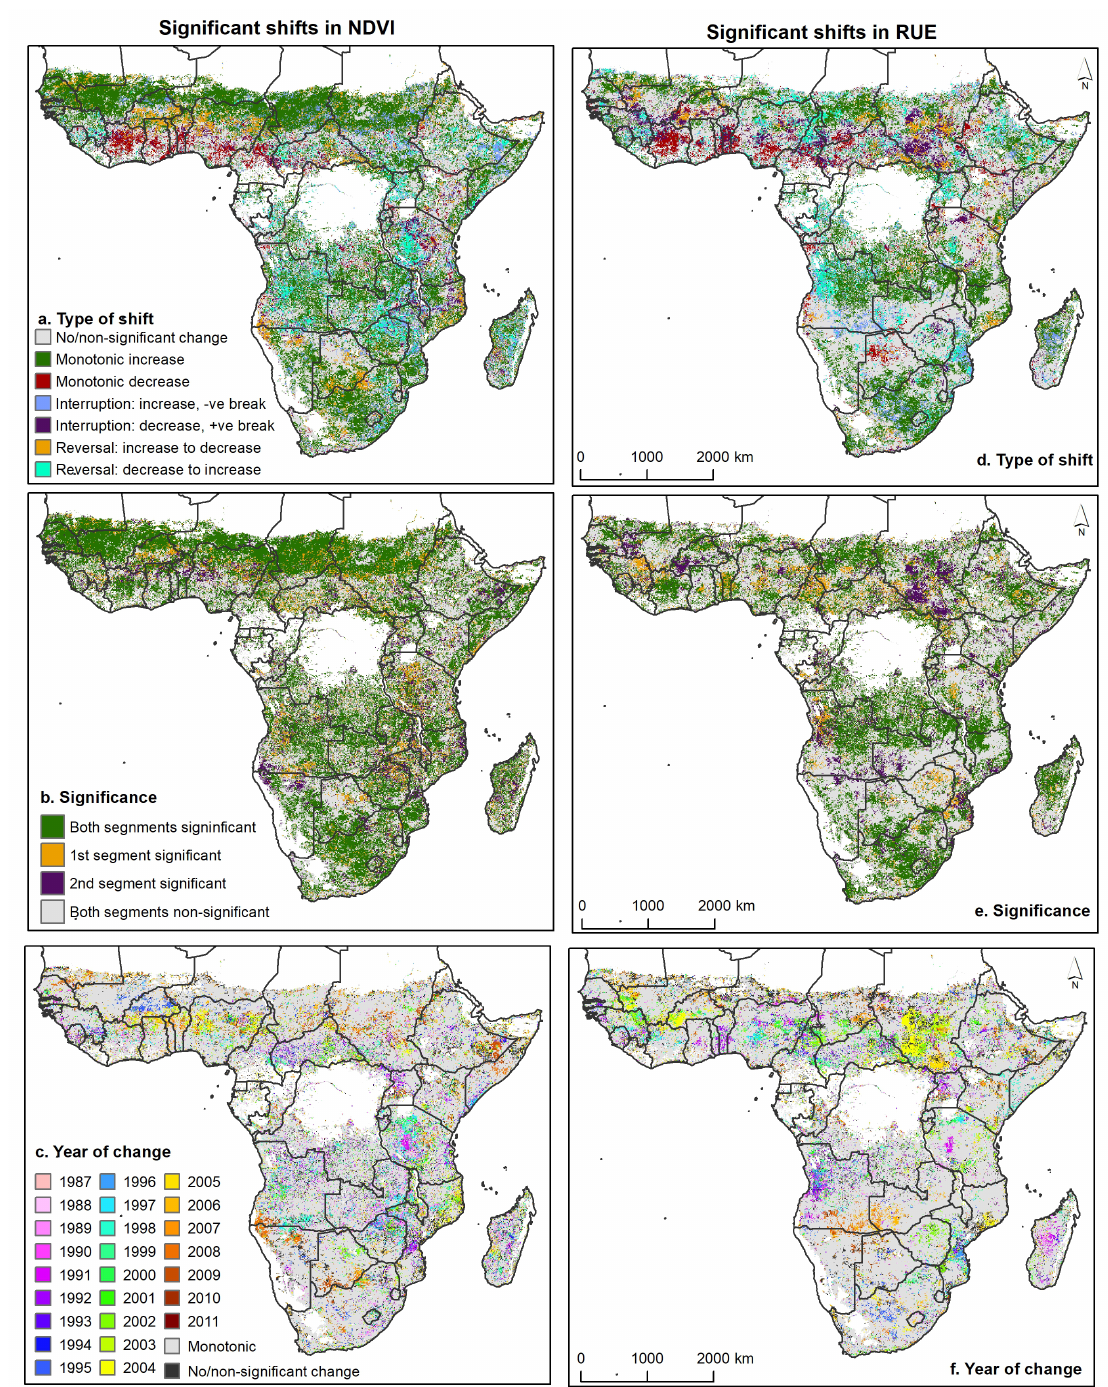
Figure 2. ( a ) Trend type, ( b ) significance of trend(s), and ( c ) date of trend shift for Normalised Difference Vegetation Index (NDVI); ( d – f ) is the same for RUE . Only pixels with a significant ( p < 0.05) change are